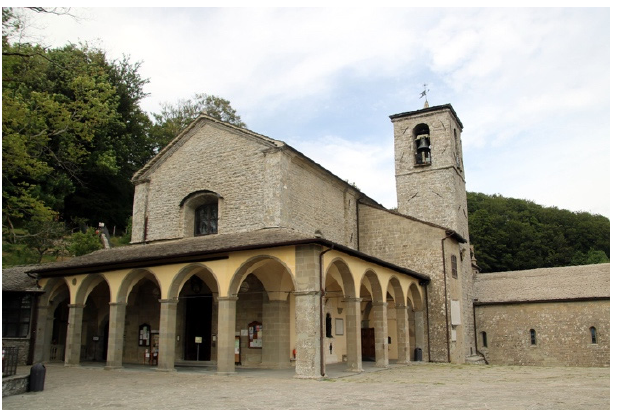
Figure 7. Jacopo Ligozzi, Chiesa Maggiore, plate D, engraving from Lino Moroni’s Descrizione del Sacro Monte dell Vernia , 1612 (photo source: Courtesy National Gallery of Art, Washington).